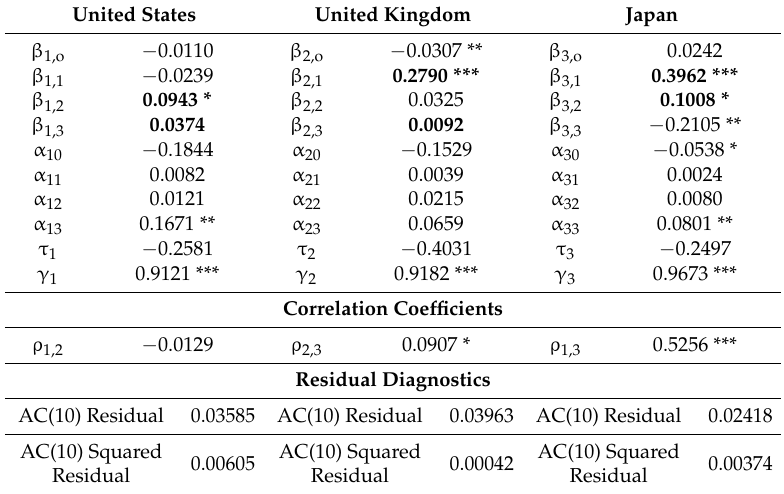
Table A8. Estimation from the multivariate MVR-EGARCH model (Islamic equities—post-crisis). United States